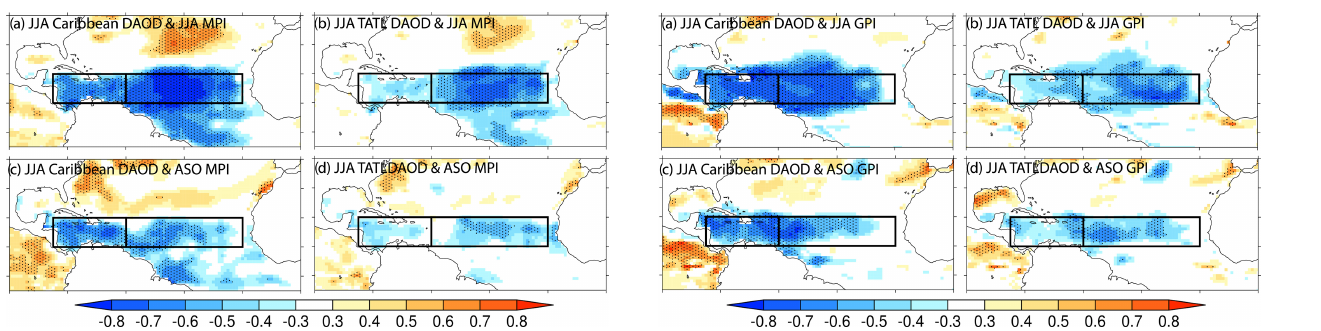
Figure 10. As in Fig. 9 but for the genesis potential index